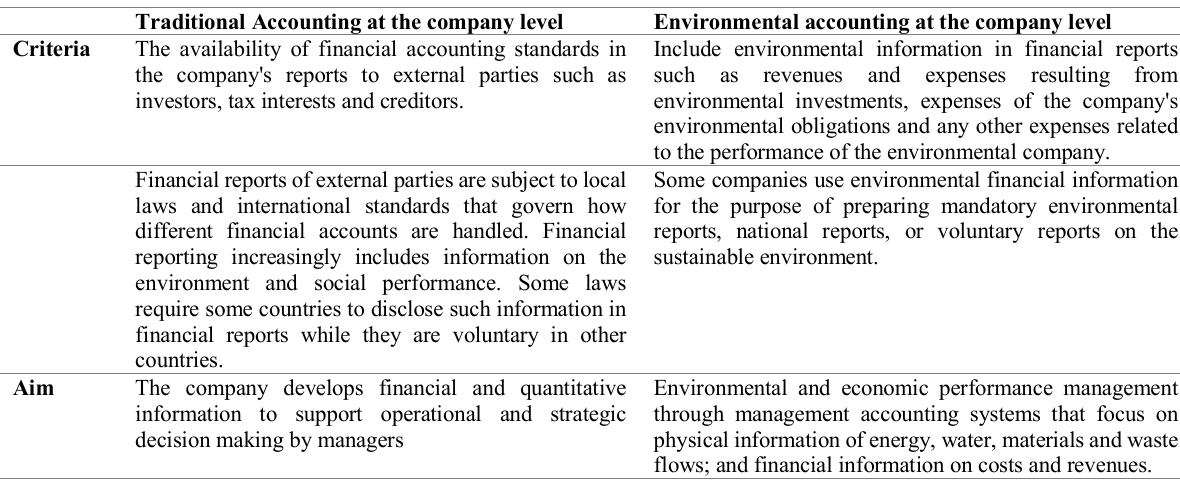
Table2: Environmental Dimensions in Accounting and its